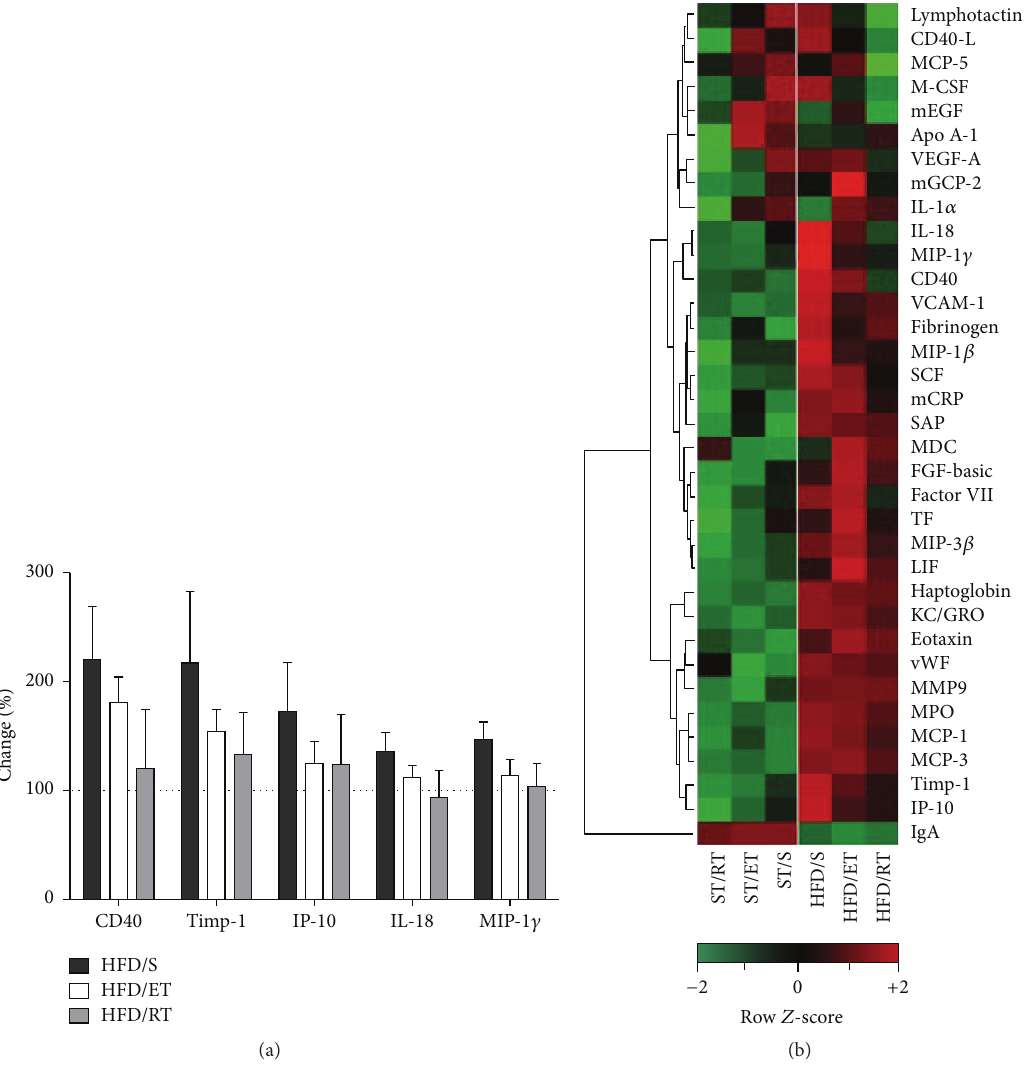
Figure 3: (a) Percent change in cytokine levels in the high fat groups relative to the ST/S group. Exercise, in particular resistance training, showed the tendency to partially reverse the HFD-induced increase in several cytokines. For each individual animal the percentage change in cytokinelevelrelativetothemeancytokinelevelsoftheST/Sgroupwascalculated.Theblackbarsrepresentthepercentagechangesincytokine production after HFD/S in comparison to the mean of the ST/S group. (b) Heat map summarizing cytokine production in plasma samples of mice fed either a ST diet or a HFD that were subjected to endurance and resistance training, as well as sedentarism. Each column shows the meanofsixanimalspergroup.Thescalerepresentsthe 𝑍 -scoresfromthelog2-transformedvaluesofeachcytokine(redindicates 𝑍 > 0 ,green indicates 𝑍 < 0 , and black indicates 𝑍 = 0 ). ST: standard diet, HFD: high fat diet, S: sedentary, ET: endurance training, and RT: resistance training. For each group 𝑛 = 6 . MCP-5: monocyte chemotactic protein-5, M-CSF: macrophage colony-stimulating factor-1, mEGF: